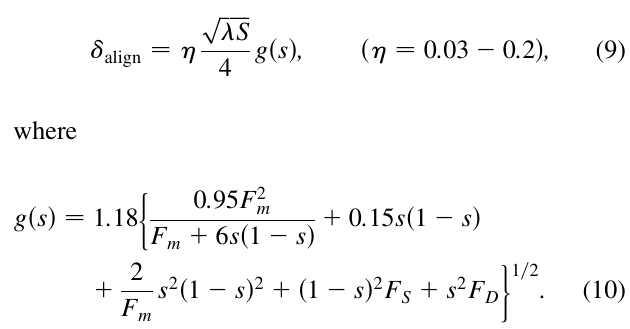
FIG. 4. (Color) Function g (cid:6) s (cid:7) for different aperture sizes with near-zero source size ( F different source sizes with near-ideal target size ( F